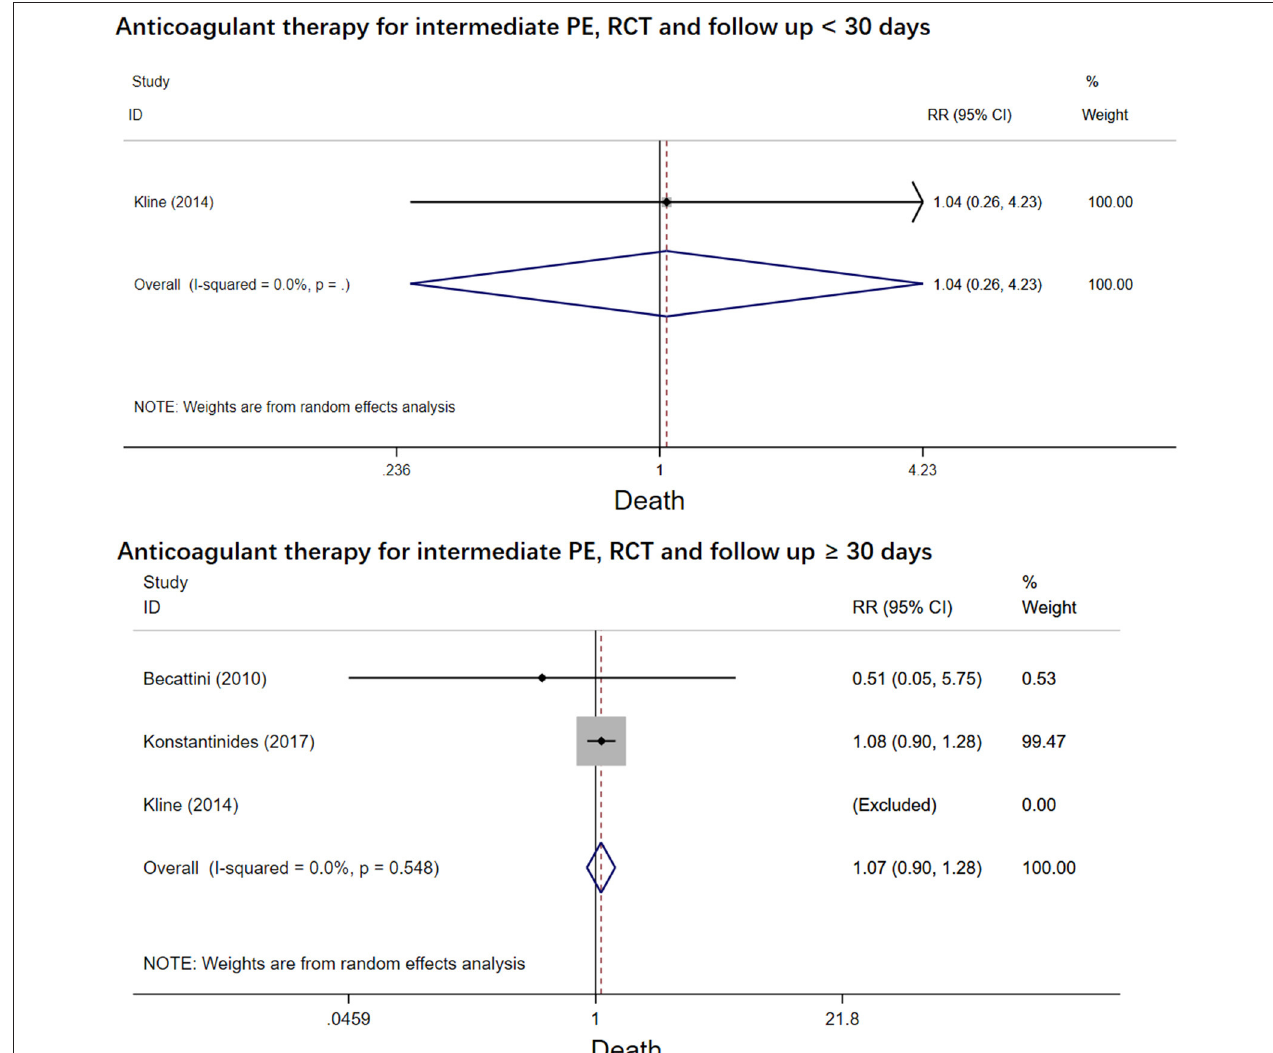
FIGURE 4 | Forest plots of tenecteplase vs. anticoagulation treatment grouped by all-cause mortality and duration of follow-up ( < 30 days or ≥ 30 days) for patients with intermediate-risk PE (excluding Meyer et al.